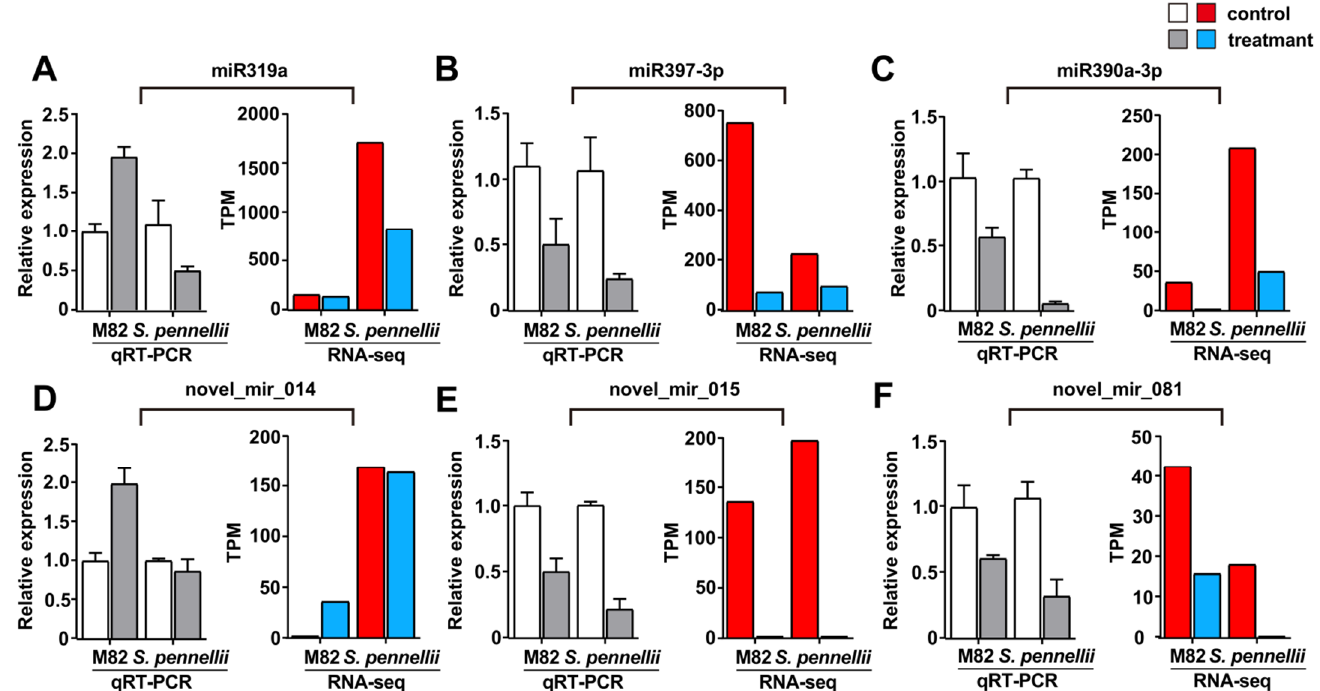
Figure 3. qRT-PCR analysis of the expression patterns of selected DE-miRNAs (three known and three novel miRNAs). ( A–F ): The qRT-PCR results are represented by the four columns on the left of each graph, and the expression levels of miRNAs are represented by the four columns on the right. The error bars represent the standard error of replicates. The white and red bars represent the control samples, and the gray and blue bars represent the samples that were treated by salt stress.